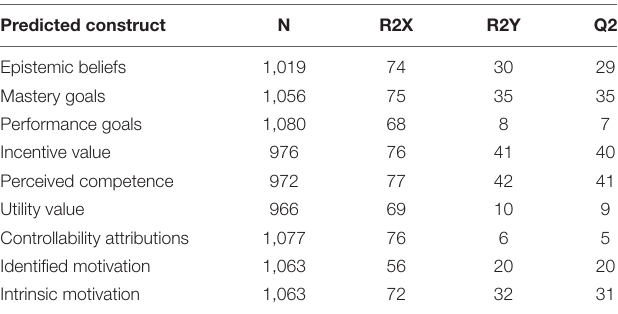
TABLE 7 | Average proportions (across all subjects) of variation in each motivation construct that can be explained (R2Y) and predicted (Q2) by the top five VIP situational (teacher) variables in Table 6